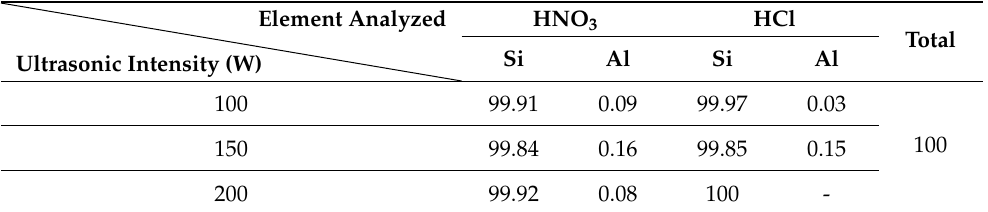
Table 10. XRF analysis results of a photovoltaic cell after drying — ultrasonic intensity (unit: wt.%). Element Analyzed